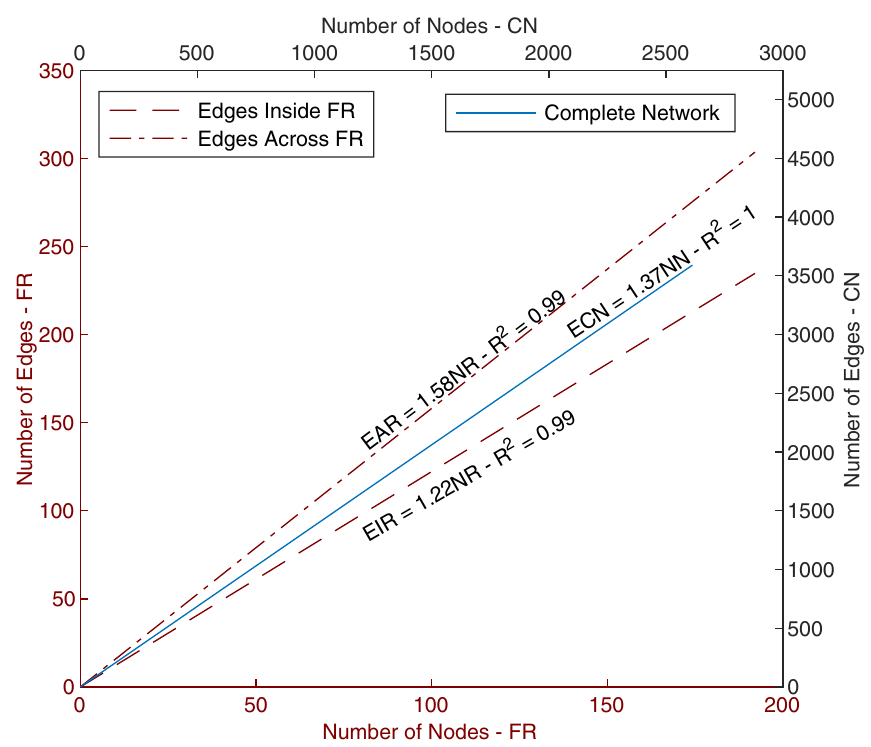
Figure 16. Number of nodes and edges inside the fusion region and the full network. Dashed lines (left and bottom axis) correspond to the relation between the number of nodes inside the fusion region (FR) and the number of edges inside it, e.g. both parent nodes of the edge lie inside FR, and number of edges across FR, i.e. at least one of the parent nodes of the edges lies inside FR. Solid line (right and top axis) correspond to the total number of nodes and edges in the complete, fused